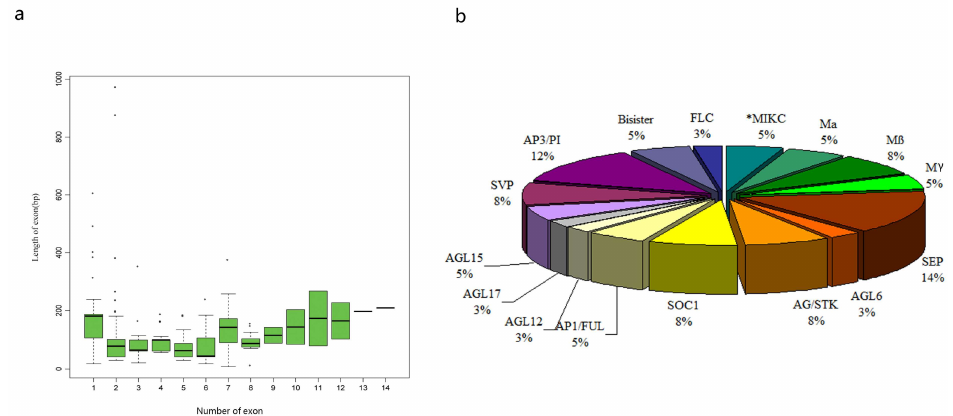
Figure 2. ( a ) Exon length distribution analysis of the carnation MADS-box genes. Exon length values were extracted from the carnation genome annotation file and then drawn the boxplot with the R language. Each box represents the exon size range in which 50% of the values for particular exon are grouped. The median is shown as a black line. ( b ) The classification and proportions of DcaMADS